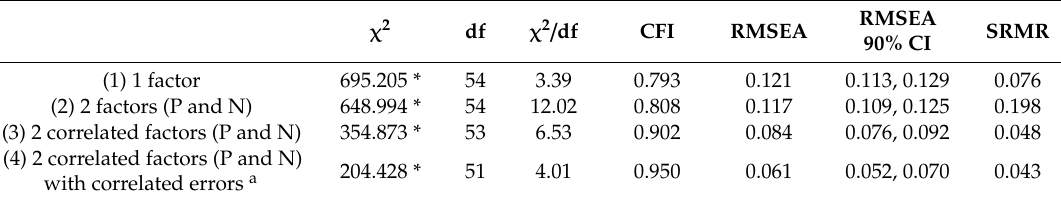
Table 1. Goodness of fit indicators of the models of a ff ect tested using confirmatory factor analysis. χ 2 df χ 2 / df CFI RMSEA